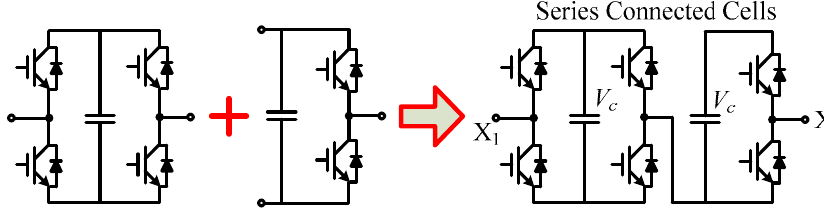
Figure 19. Derivation of hybrid-series-connected sub-module (HSSM) with FBSM and HBSM cells.